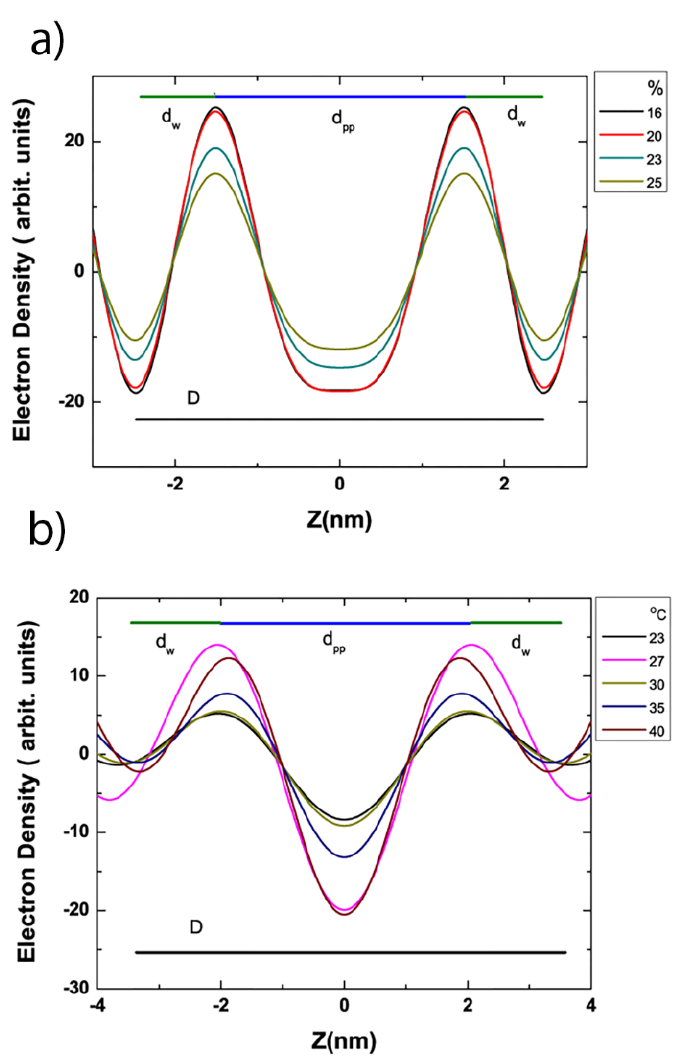
Figure 4. Electron density profiles for the coexisting ( a ) L β′ and ( b ) L α phase at 0.1 mol% DHA-PE at different temperatures. The center of the bilayer is at Z = 0